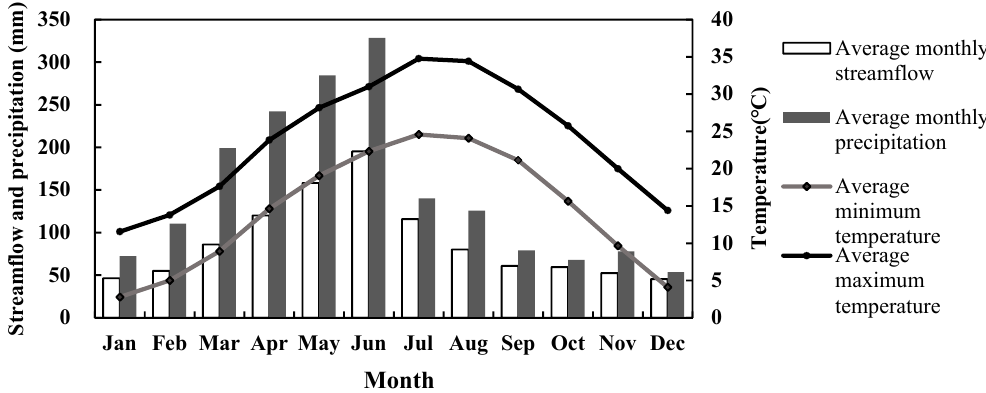
Figure 2. Average monthly precipitation and streamflow from 1961 to 2016, with maximum and minimum temperatures from 1961 to 2011 in the Jiujushui watershed.